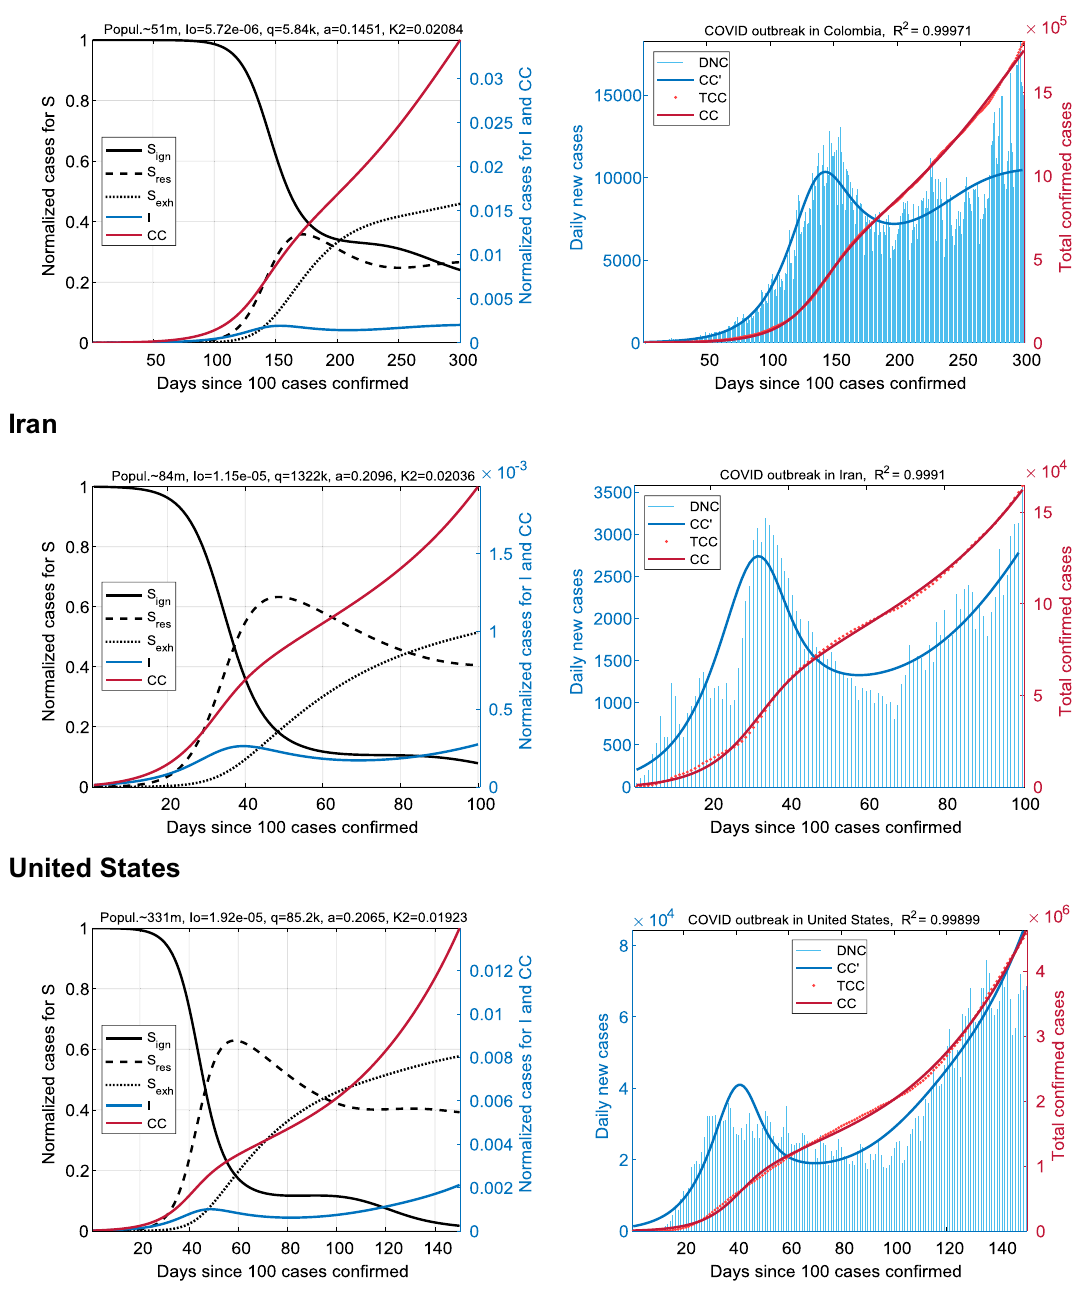
Figure 5. Coronavirus outbreaks in countries with extremely high exhaustion rate. Results for Colombia (top panel), Iran (center), and United States (bottom). The main trend here is the rapid accumulation of exhausted people S exh (up to ~ 50% over a period of 50–150 days, if taken from the peak of the first wave). At the same time, the S ign fraction can remain quite small. The first wave of I(t) rapidly turns into the second one without a significant decline relative to the peak values. The time intervals for the simulations were chosen